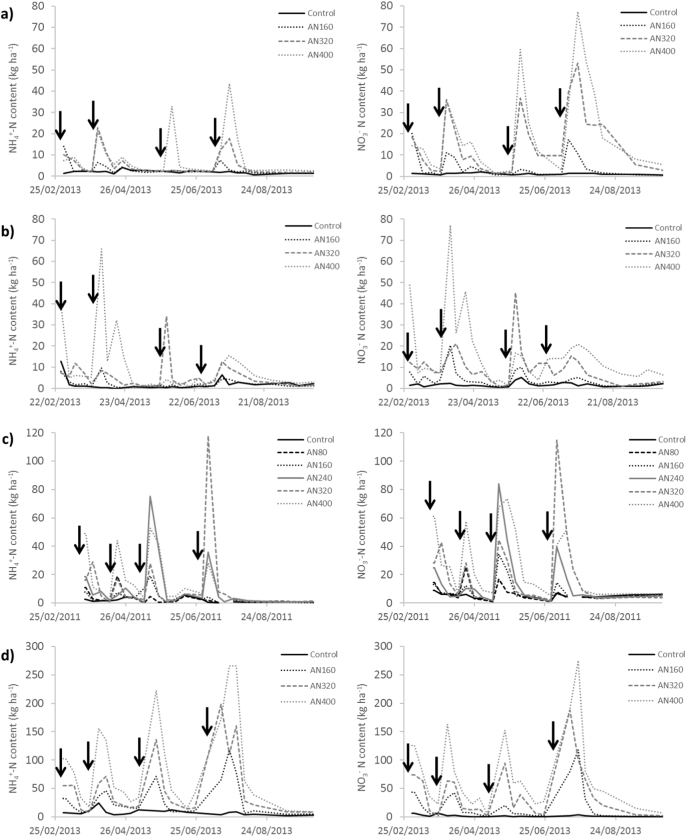
Soil mineral nitrogen content (NH4+ and NO3−) for the AN treatments at increasing rates from 0 to 400 N ha−1. Note that scales are different between sites. Data for Crichton is not presented because of missing data during the first two months of the experiment. a) Drayton, b) North Wyke, c) Hillsborough, d) Pwllpeiran.